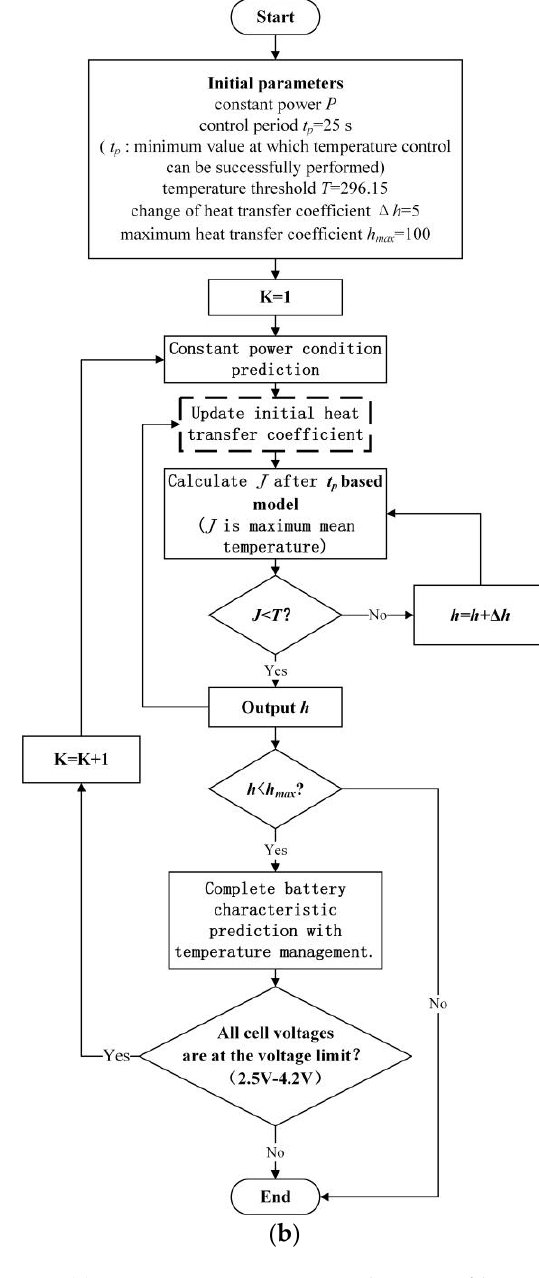
Figure 13. Temperature-control strategies. ( a ) Strategy 1: Constant search range of heat transfer coefficient. ( b ) Strategy 2: Variable search range of heat transfer coefficient.